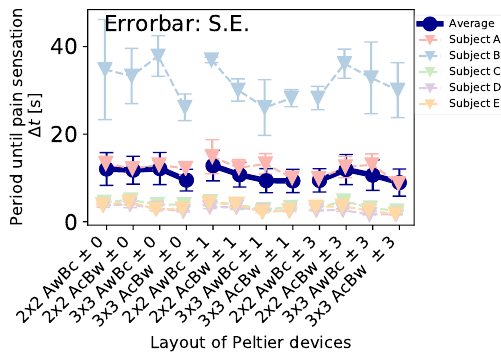
Figure 6. ∆ t ’s result of spatial distribution